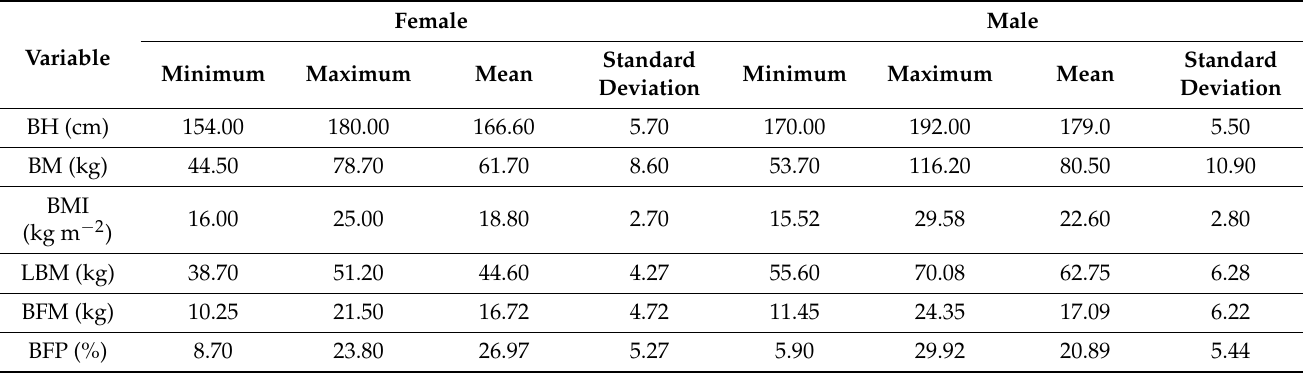
Table 1. Descriptive statistics for basic somatic characteristics and body composition.